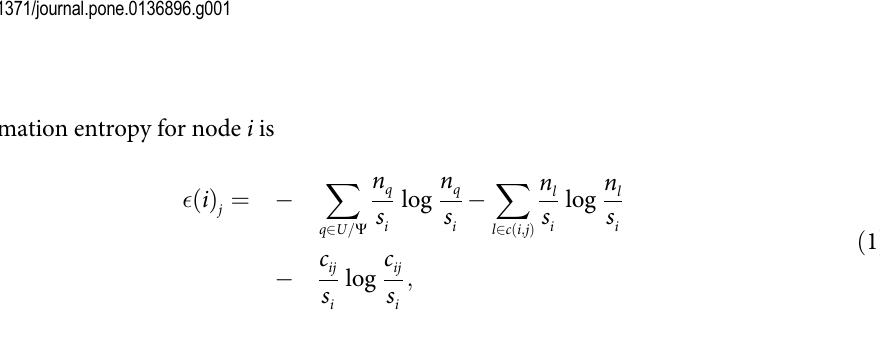
Fig 1. A simple example of the network evolution driven by homophily in local